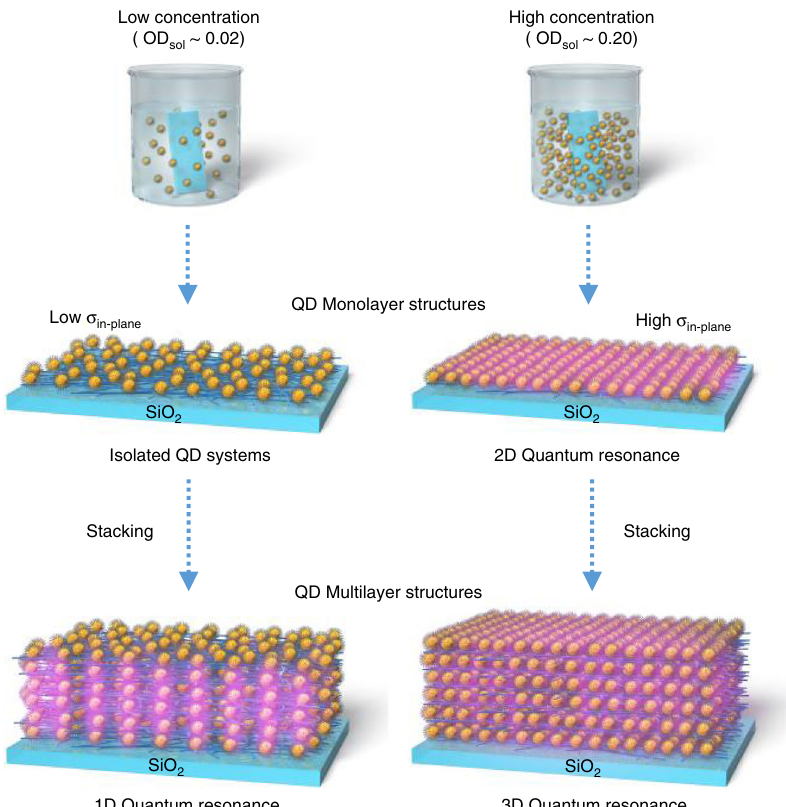
Fig. 1 Schematics of quantum dot (QD) layer structures in which the 1D, 2D, and 3D quantum resonances occur. We controlled the in-plane QD density ( σ in-plane ) by changing the concentration of the QD solution and hence the optical density of the QD solution (OD sol ) using a layer-by-layer assembly method. The left and right sides of the fi gure represent QD layer structures with low and high σ in-plane , respectively. If σ in-plane is low, the quantum resonance in the in-plane direction is suppressed (isolated QD systems). When QD multilayer structures are fabricated under the conditions of low σ in- plane , the quantum resonance occurs only in the stacking direction, that is, the 1D quantum resonance is realised. In the QD monolayer structure with high σ σ in-plane , only the in-plane 2D quantum resonance occurs. In the QD multilayer structures with high in-plane , the quantum resonance appears not only in the stacking direction but also in the in-plane direction. In other words, the 3D quantum resonance occurs in the 3D QD superlattices. The coupled electronic states are represented by translucent purple